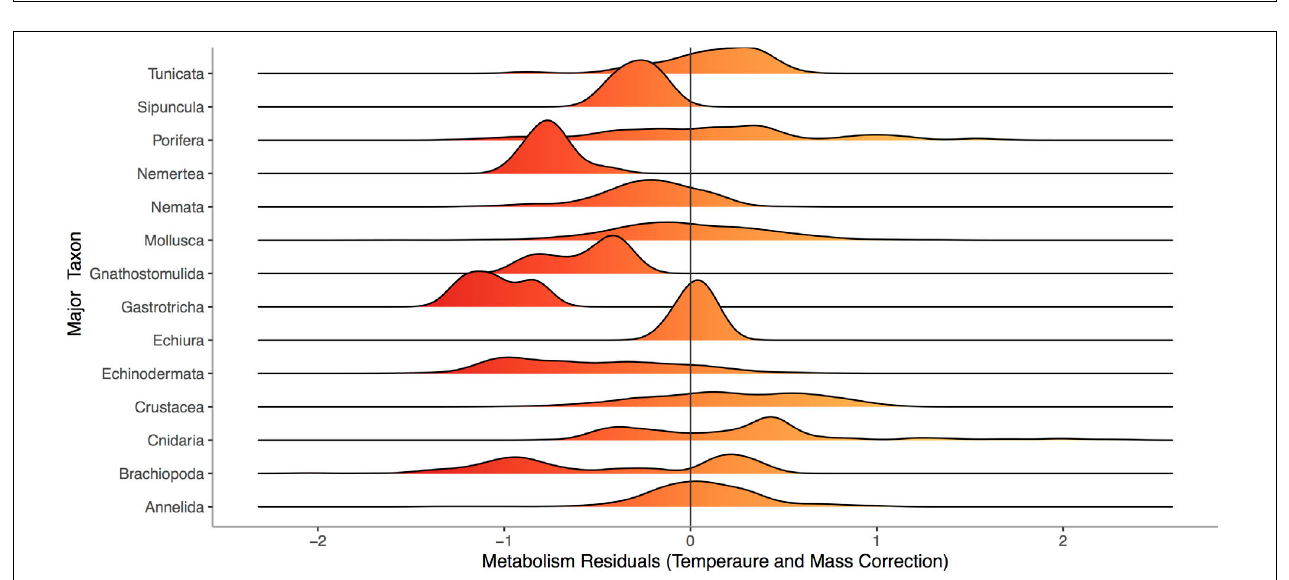
FIGURE 1 | Log 10 Metabolic Rate (Joules per Day) verses Log 10 Mass (Joules) for marine invertebrates. Data represent a global database from Brey et al. (2010) on relationships between mass, elemental composition and energy content for marine invertebrates. This includes data for 13,478 individuals from 444 species, 336 genera, 46 orders, 29 classes, and 14 phyla ranging in depths from 1 to 4,420 meters. Colors denote large negative (red) to large positive (orange) residuals of the relationship between respiration and mass.